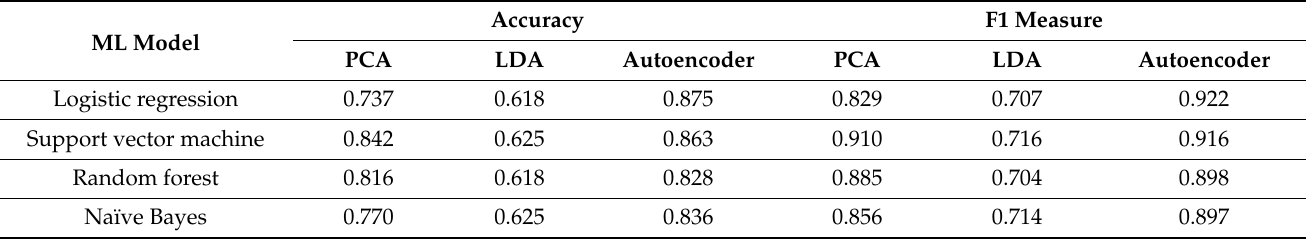
Table 7. Classifiers accuracy and F1 score analysis with various dimensionality reduction